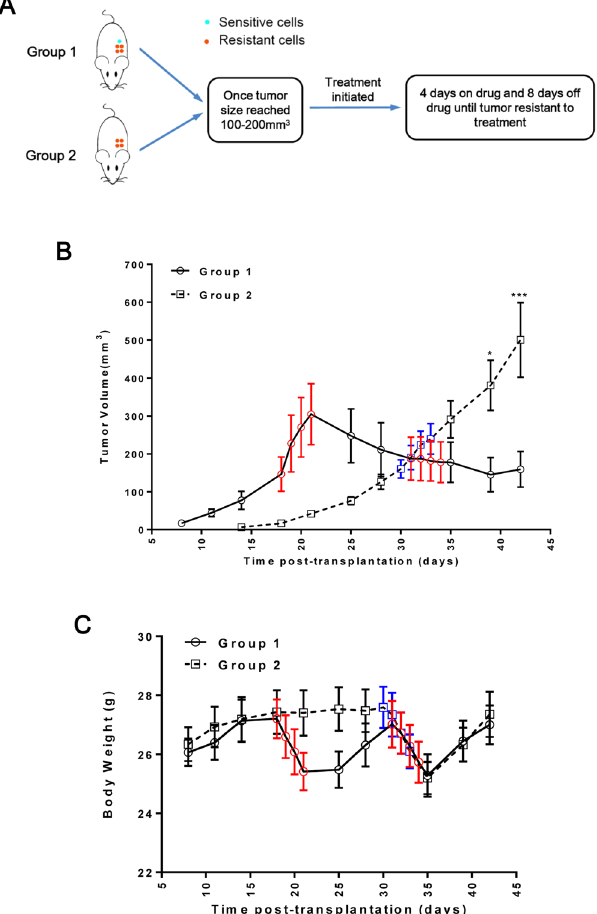
Figure 5. ( A ) Schematic representation of the tumor treatment assay in ( B ). For group 1, 2 × 10 6 HeLa/ddp cells mixed with 5 × 10 5 HeLa cells were injected subcutaneously into mice. For group 2, 2 × 10 6 HeLa/ddp cells alone were injected subcutaneously into mice. ( B ) Tumor growth kinetics of group 1 (n = 6) and 2 (n = 7); both the red and blue dots represent one dose of ddp (2 mg/kg). The error bars indicate s.e.m. ( C ) Body weights of the mice in groups 1 and 2 throughout the treatment period; both red and blue dots represent one dose of ddp (2 mg/kg). The error bars indicate